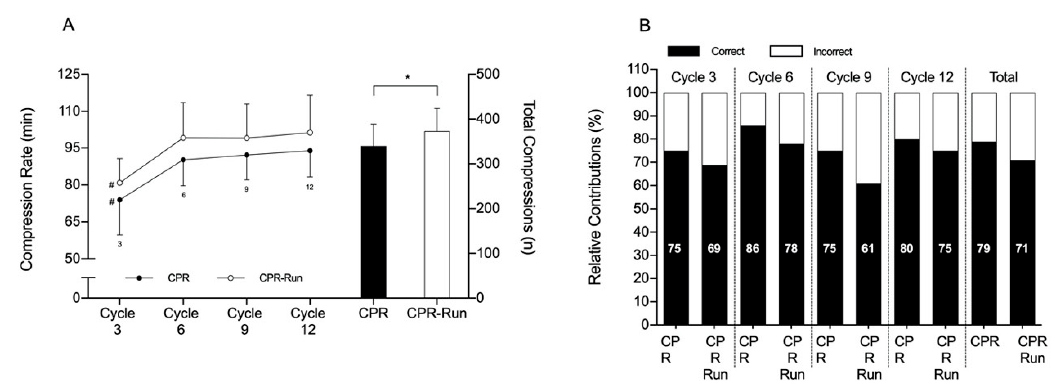
Figure 3. Mean ± SD values for compression rate and total number of compressions ( A ), and mean relative values for correct and incorrect compressions ( B ) over the first, second, third and fourth (cycle three, six, nine and 12, respectively) three complete CPR cycles, when preceded by 4-min baseline (CPR) and 100 m maximal run (CPR-Run), conditions; three, six, nine, 12 different from cycles three, six, nine and 12 of the CPR-Run condition, respectively; # different from cycles six, nine and 12 within the same condition; * differences between CPR and CPR-Run condition ( p < 0.05).